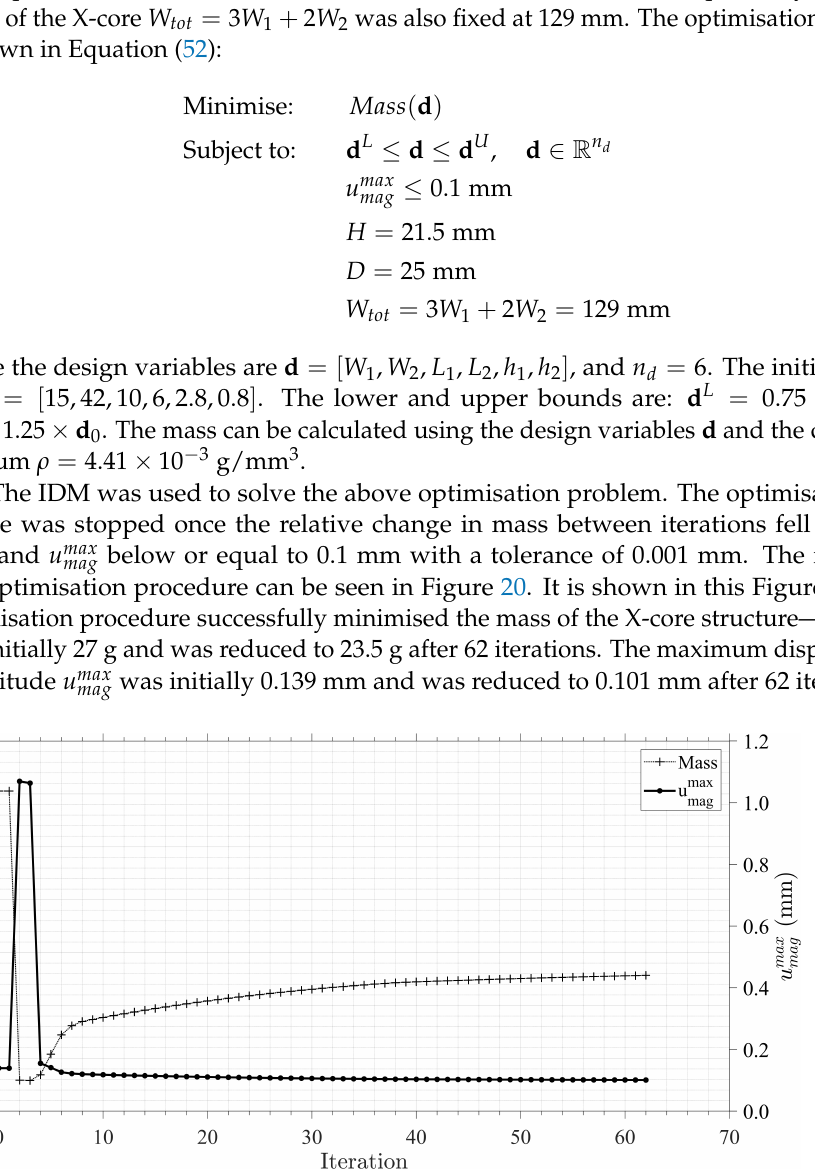
Figure 20. Results of the shape optimisation of the X-core